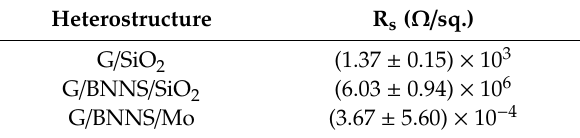
Table 1. Graphene layer sheet resistance measurements for di ff erent combinations of